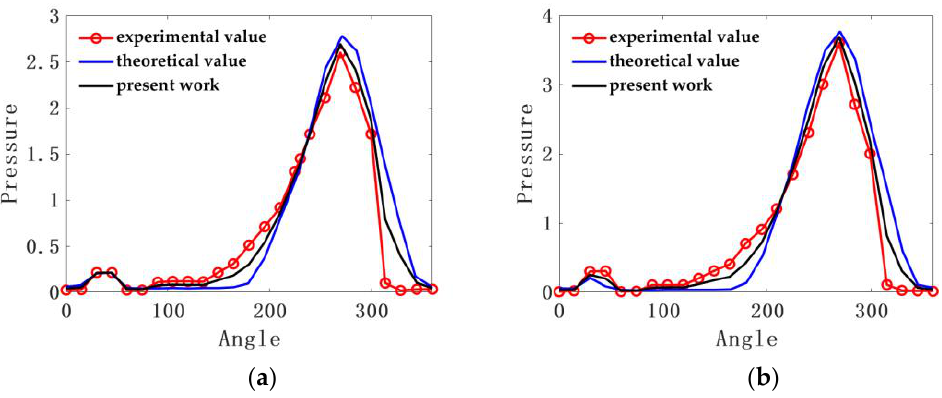
Figure 8. Oil film pressure distribution. ( a ) the load is 6 KN; ( b ) the load is 8 KN.